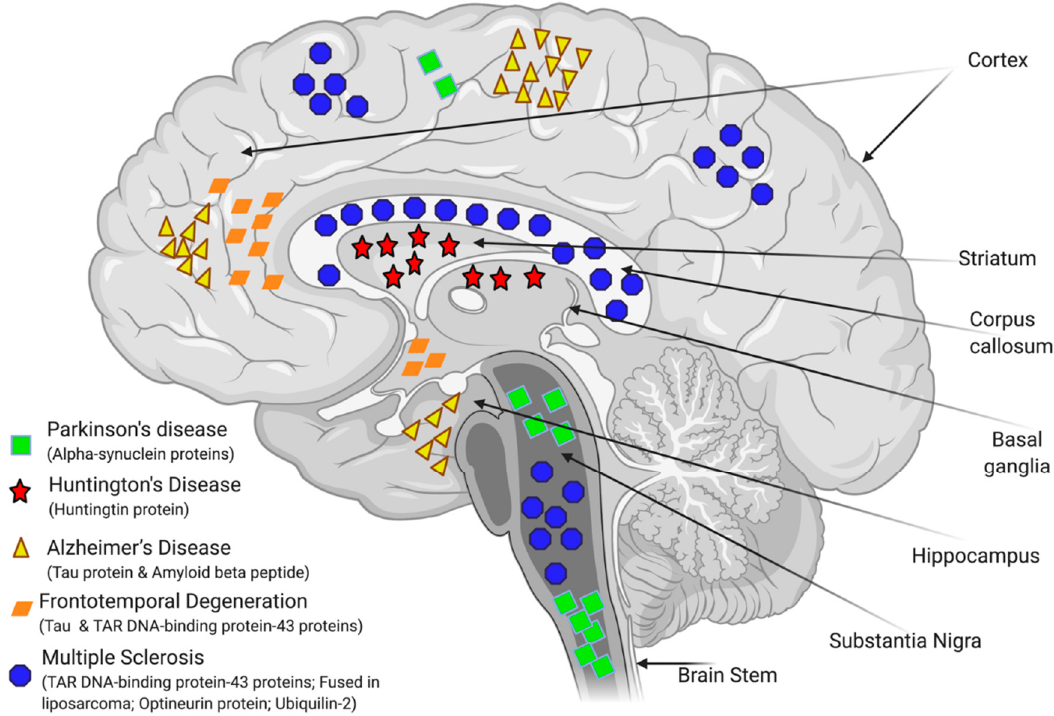
Figure 4. Schematic summary of the regions of the brain affected by major neurodegenerative diseases (NDDs) and the misfolded proteins that are involved in their pathology. Adapted from [90,91].